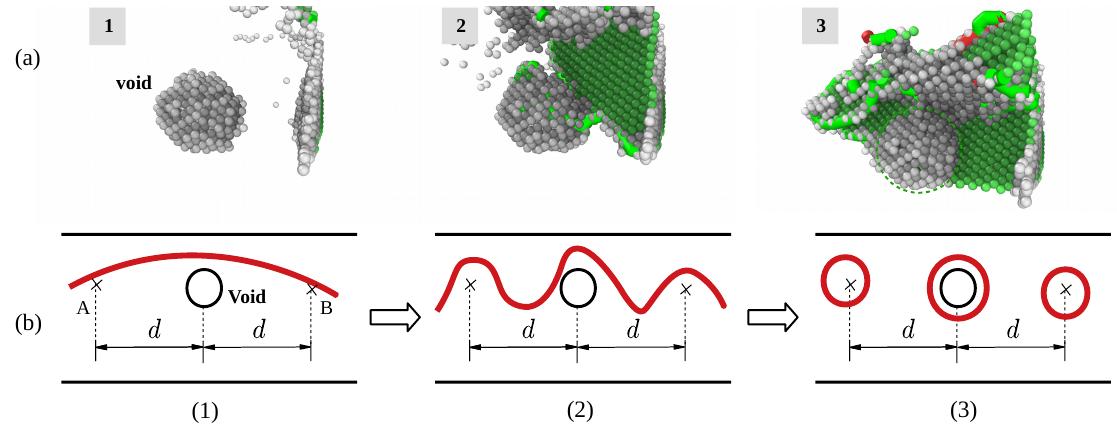
Figure 11. ( a ) Orowan process occurred inside α 2 phase grain (removed atoms with regular arrangement).( b ) Schematic of Orowan process.